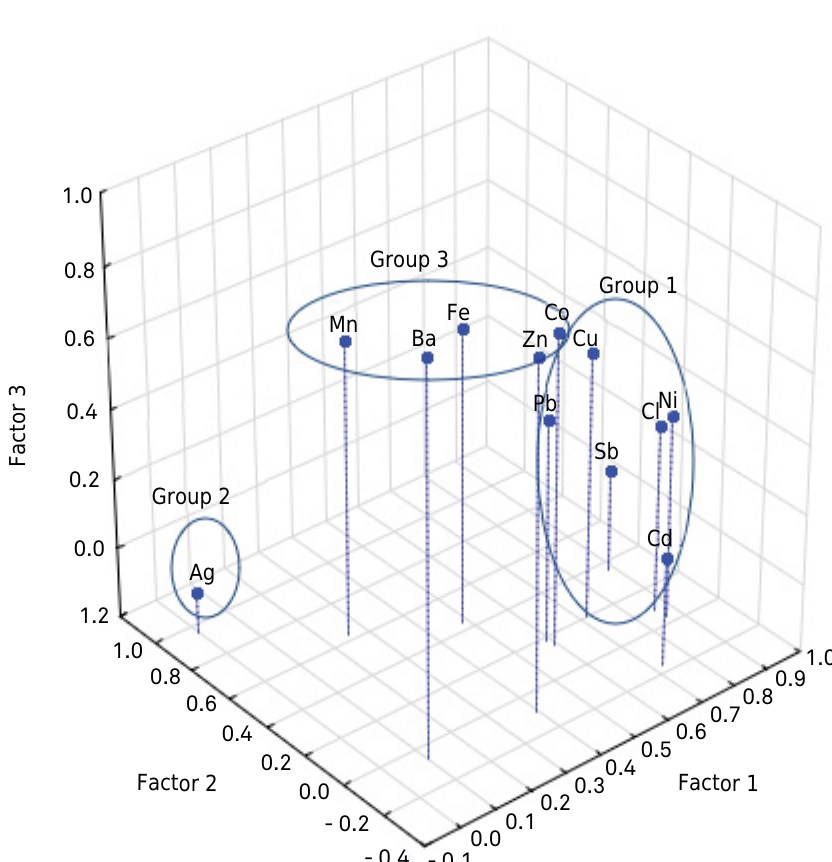
Figure 2. Graphical display of the principal components influencing the heavy metal concentrations in